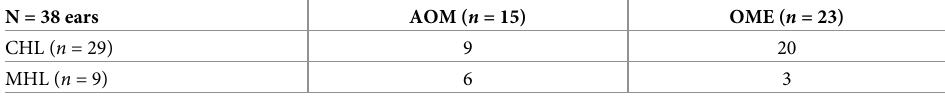
Table 2. Patterns of hearing loss according to the diagnosis of middle ear effusion.